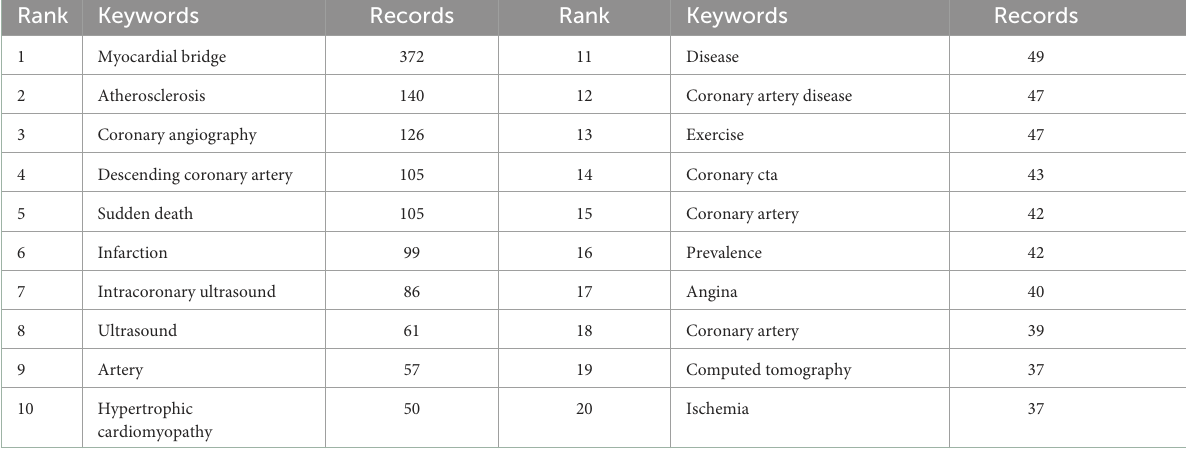
TABLE 3 Top 10 keywords in terms of records in myocardial bridge research.